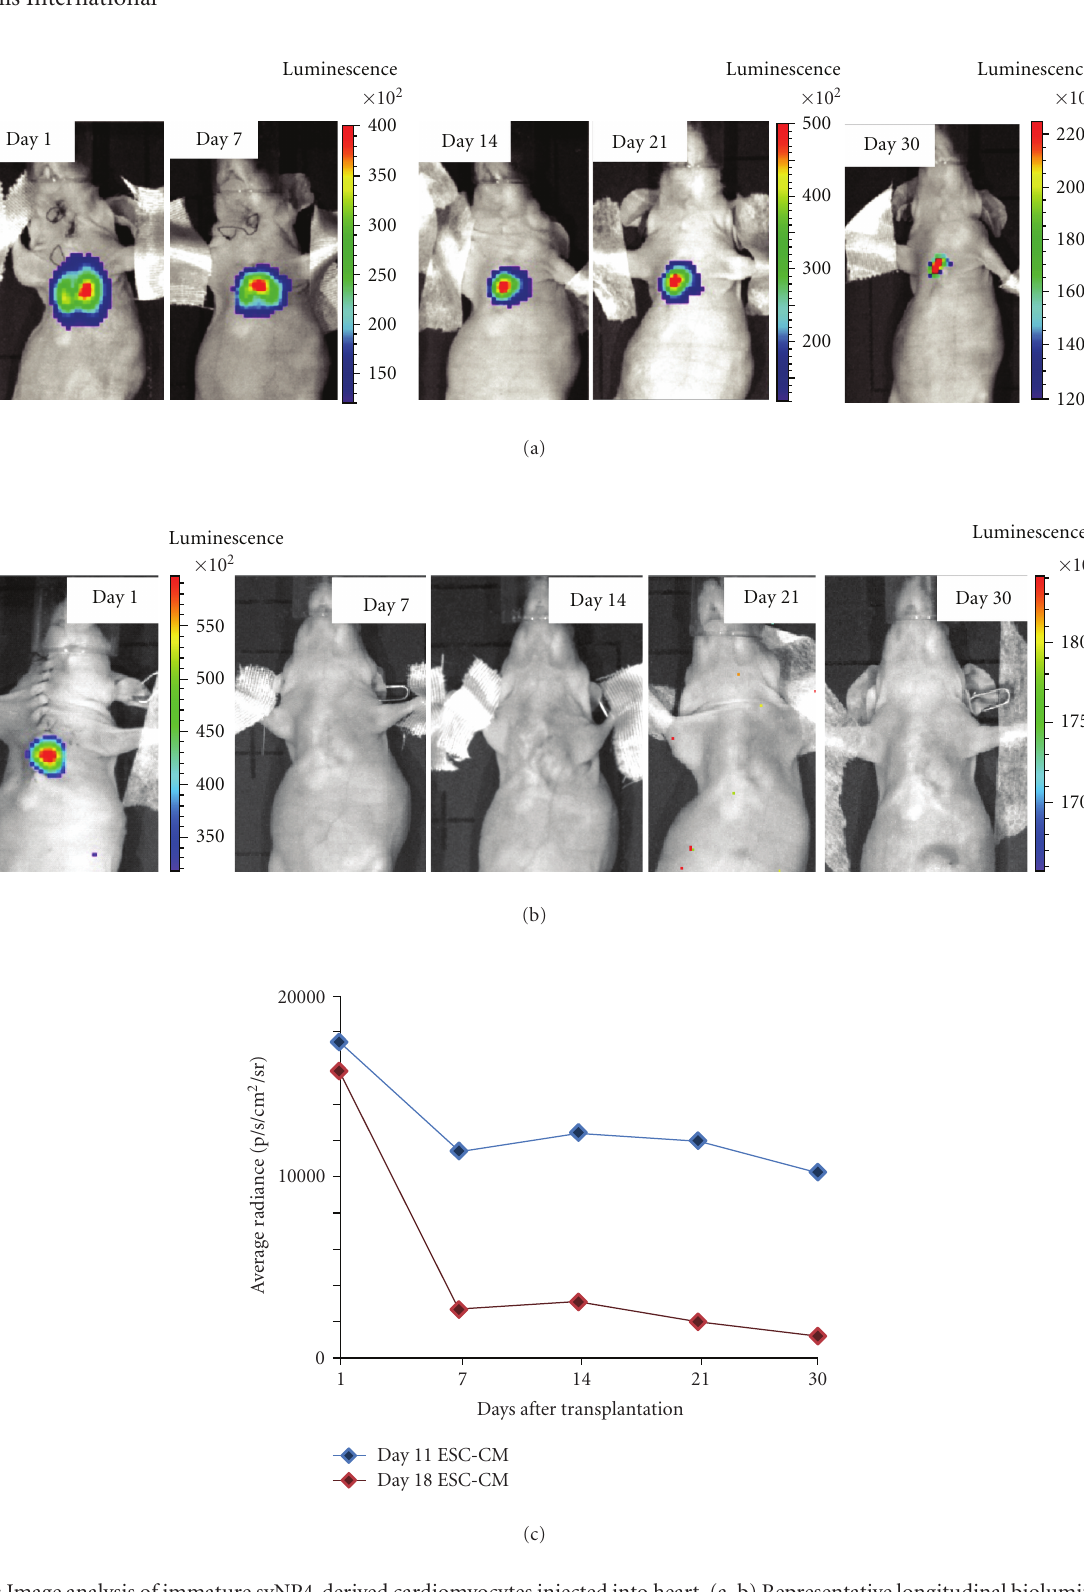
Figure 3: Image analysis of immature syNP4-derived cardiomyocytes injected into heart. (a, b) Representative longitudinal bioluminescence imaging (BLI) of athymic nude mice following intramyocardial transplantation of 2 × 10 6 syNP4-derived CMs stably expressing a firefly luciferase reporter construct. The images shown in (a) involved CMs isolated at day 11 in culture, while those shown in (b) involved CMs isolated at day 18. (c) Analysis of BLI data from two sets of ESC-CMs shows a robust cardiac signal on day1, which decreases substantially in the first week, achieves a plateau from days 7 to 21, and then declines at 1 month, whereas those cells, which are slightly more mature, have minimal signals within 7 days of